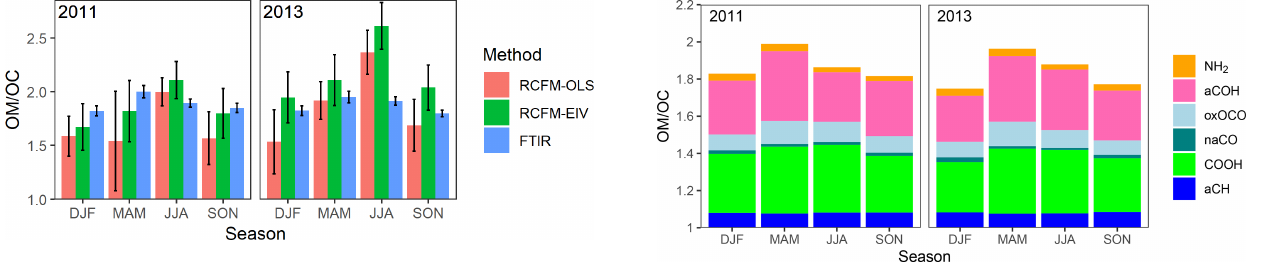
Figure 11. Mean OM / OC ratios partitioned by FG contributions for the FTIR estimates shown in Fig.